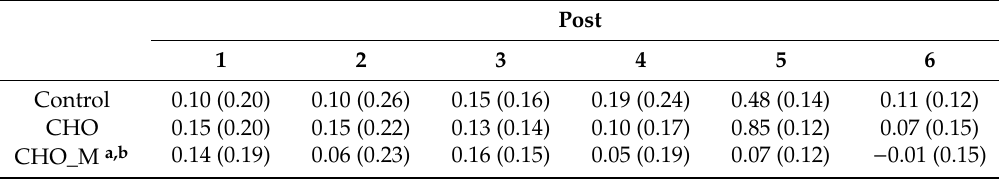
Table 2. The sprint performance—di ff erence between pretest and each of the posttests (M ± SD).